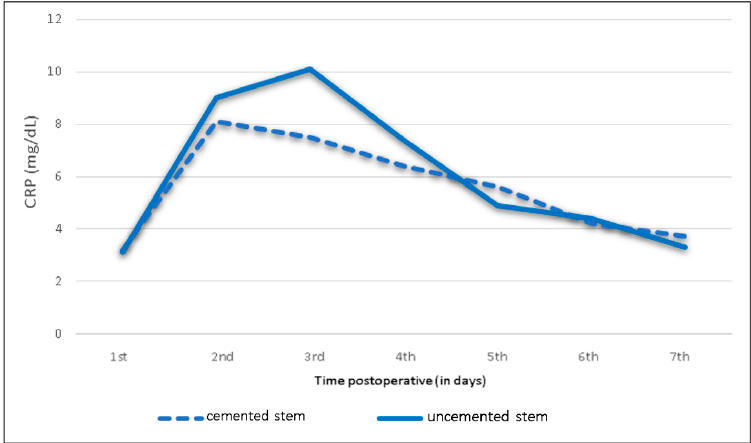
Figure 8. Mean C-reactive protein levels and trends following shoulder arthroplasty depending on application of bone